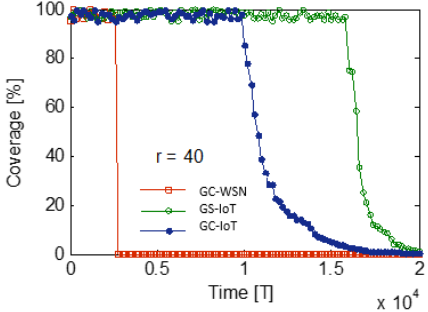
Figure 17. Life span comparison with literature.